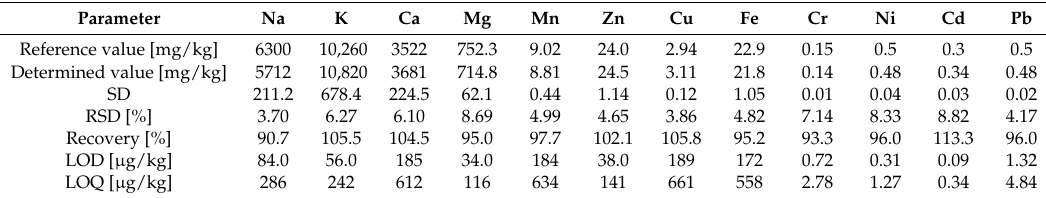
Table 8. Selected validation parameters for metal